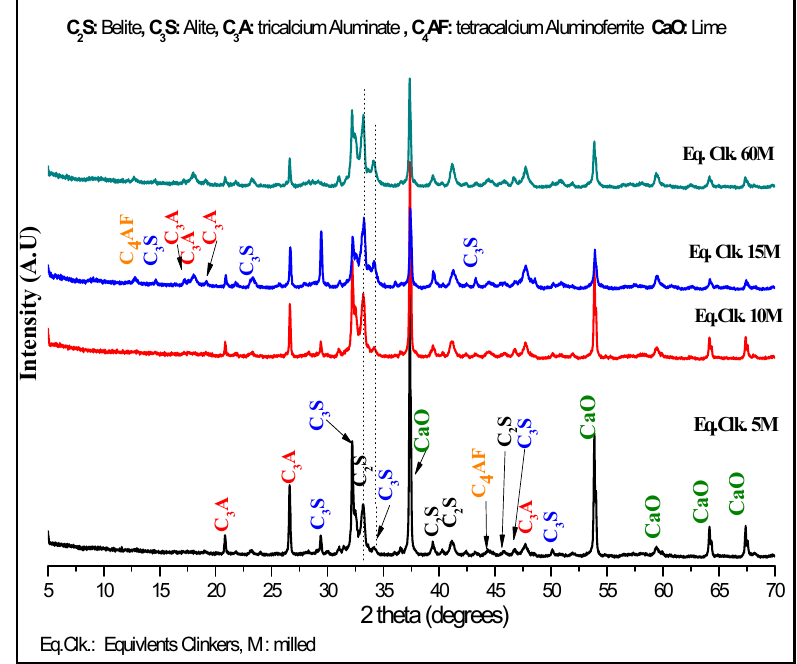
Figure 7. X-ray diffraction patterns of the different clinkers produced by mechanosynthesis. Peaks of a C 3 A (tricalcium aluminate Ca 3 Al 2 O 6 ) structure have been found in the positions 2 θ : 20.97° (2 3 0), 26.76° (4 2 1), 47.66° (8 0 0) in all X-ray diffraction patterns of the equivalent clinkers (eq. clk.). In addition, the additional peaks are identified in the 2 θ positions 14.20